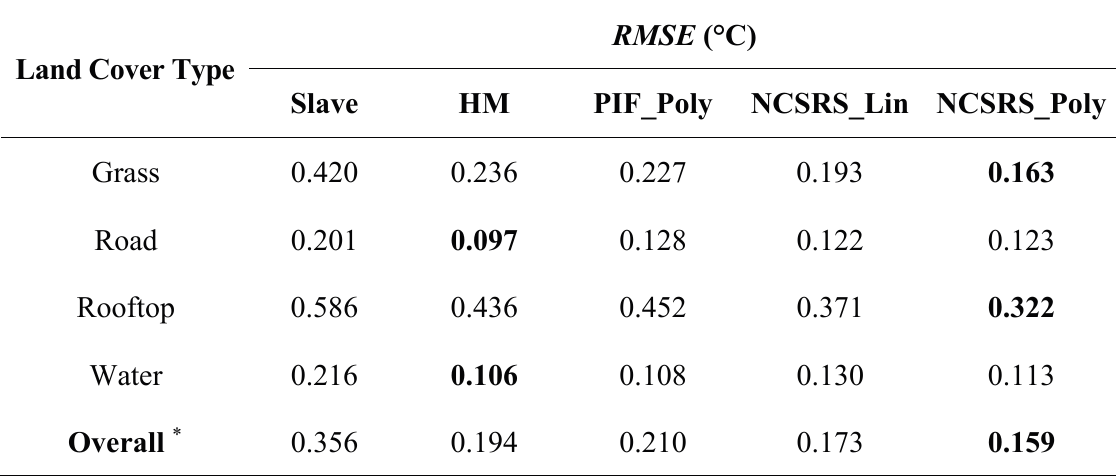
Table 1. The overall RMSE of four different land cover types, for each of the four different relative radiometric normalization methods evaluated in this study. Bold values represent the lowest RMSE of each class and overall RMSE calculated for each